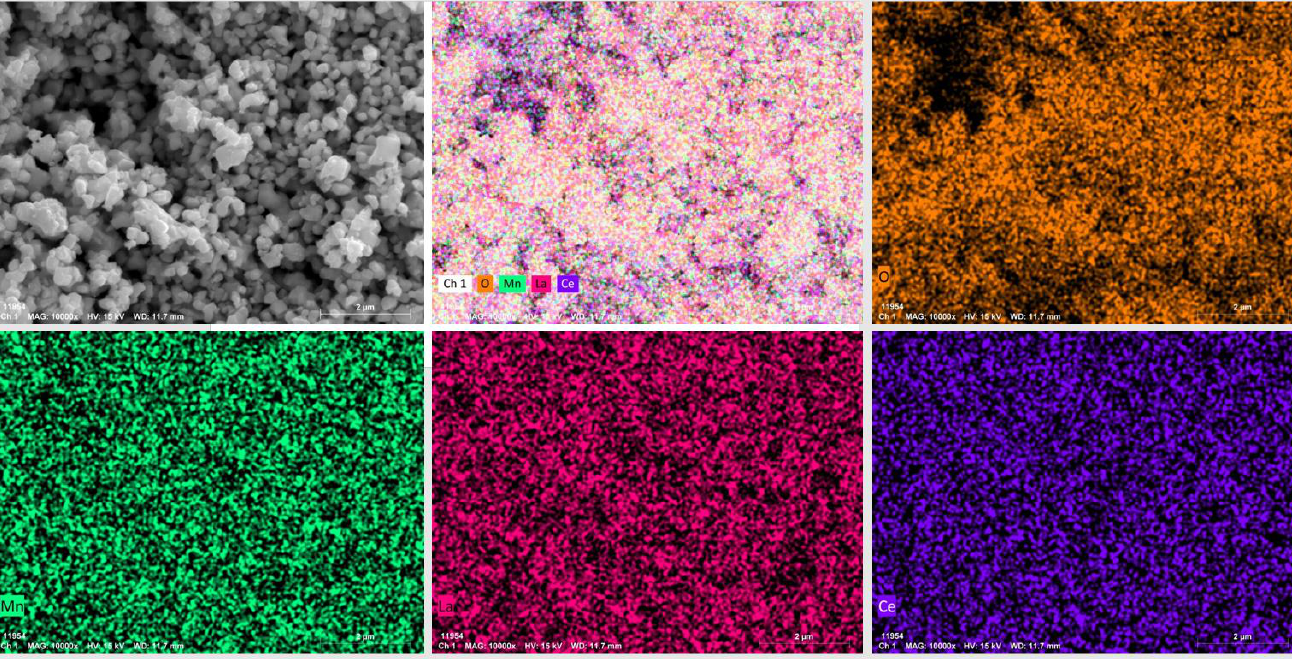
Figure 3. EDS spectra of fresh 0.3LCMO.